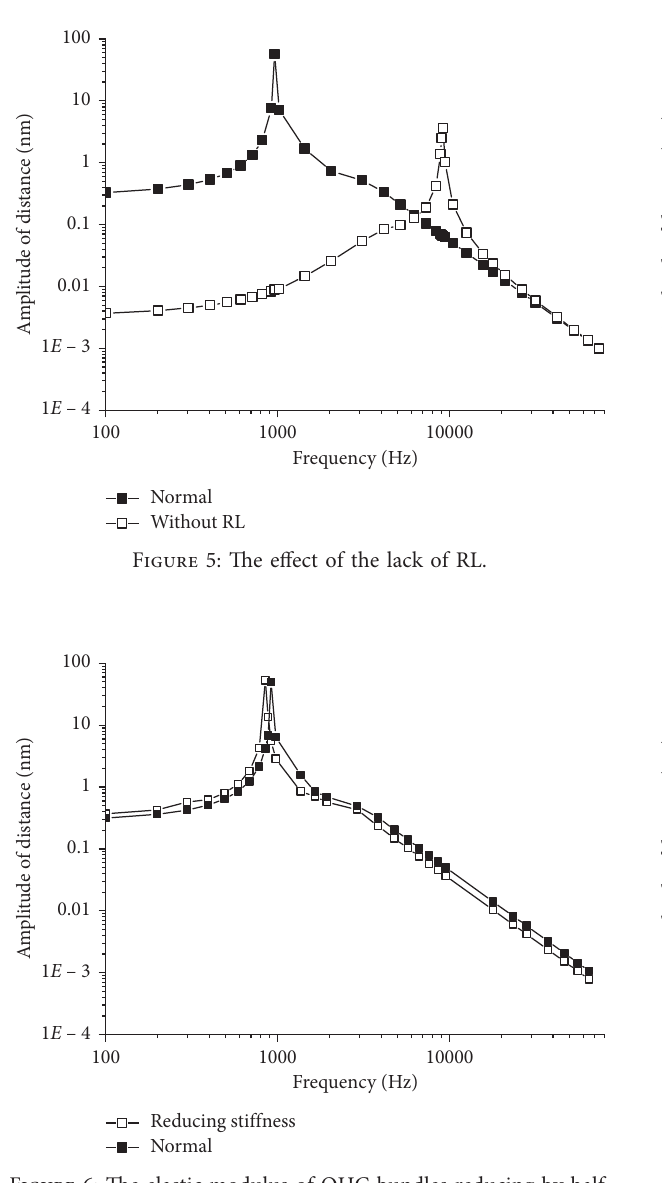
Figure 6: The elastic modulus of OHC bundles reducing by half.